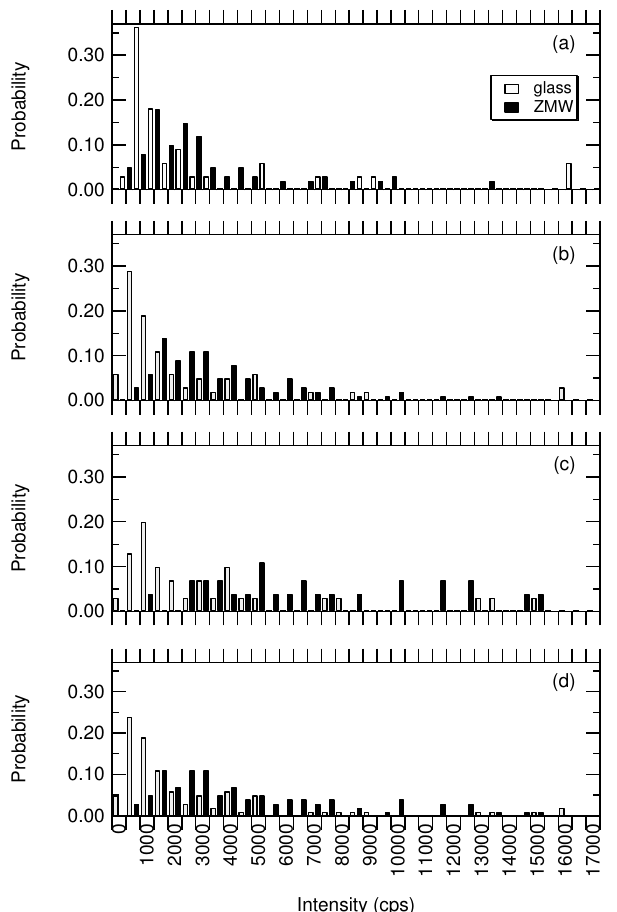
Figure 5. Probability distributions for the observed intensity of Atto647 on glass and in ZMWs for molecular states corresponding to ( a ) two-state trajectories, ( b ) state 1 in three-state trajectories, ( c ) state 2 in three-state trajectories, and ( d ) all states